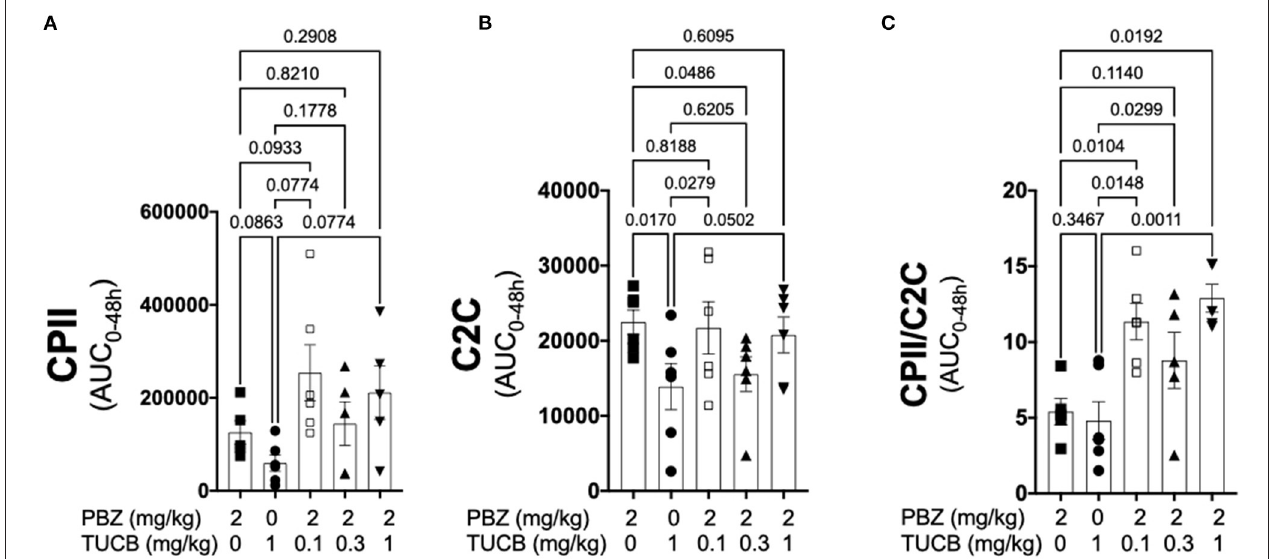
FIGURE 5 | Combined inhibition of soluble epoxide hydrolase (sEH) and cyclooxygenases (COX) during joint inflammation favored collagen synthesis over degradation. Synovial fluid concentrations of the biomarker of type II collagen synthesis CPII (A) , type II collagen degradation C2C (B) and the synthesis-degradation ratio (C) calculated based on 48-h aggregate concentrations (AUC) in synovial fluid from an equine synovitis model induced by intra-articular injection of lipopolysaccharide (LPS; 3 µ g) into the radiocarpal joint ( n = 6 horses) as measured using ELISA techniques. Horses were treated intravenously with the sEH inhibitor trans -4-{4-[3-(4-Trifluoro-methoxy-phenyl)-ureido]-cyclohexyloxy}-benzoic acid (TUCB), the non-selective COX inhibitor phenylbutazone (PBZ) or both, at the indicated doses marked below the graphs, at the same time as the intra-articular LPS injection. Data are shown as individual values (symbols) and mean ± SEM (columns), and p -values are shown above each respective comparison (Mixed-effects model corrected for multiple comparisons by controlling the False Discovery